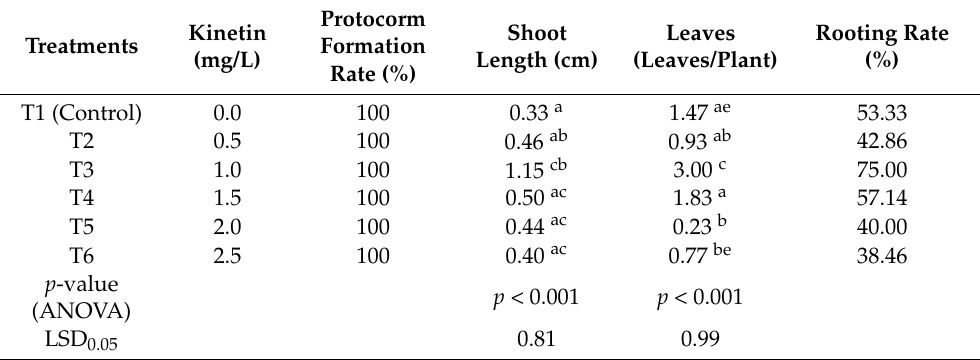
Table 2. Effect of kinetin on the regeneration efficiency of the D. anosmum Lindl. protocorms (10 weeks after culturing).